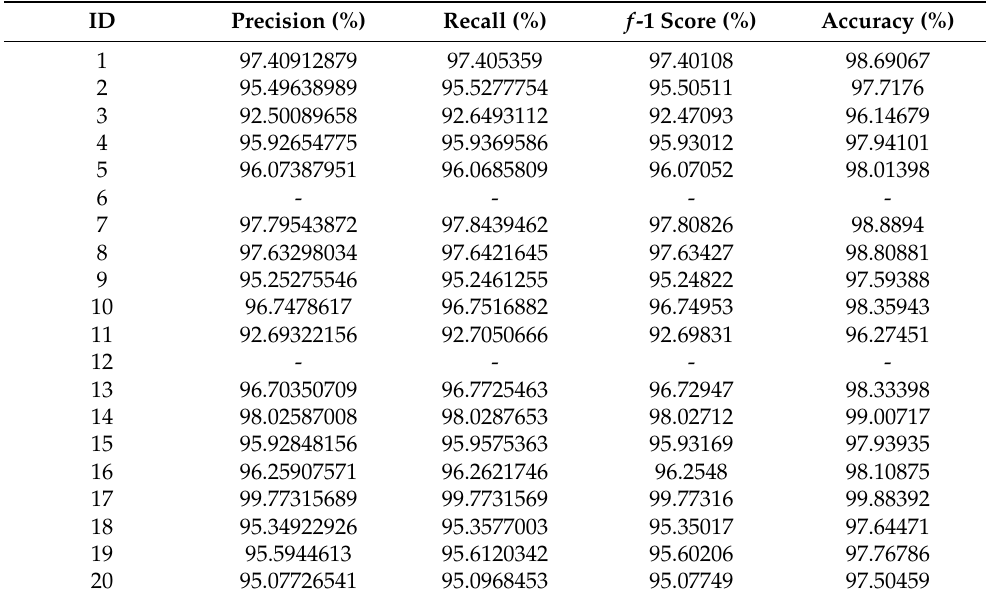
Figure 9. The accuracy of the individual TSV prediction model using the bagged trees algorithm. Table 4. Performance metrics of individual prediction model with the bagged trees Table 5. Performance metrics of individual prediction model with the bagged trees algorithm.